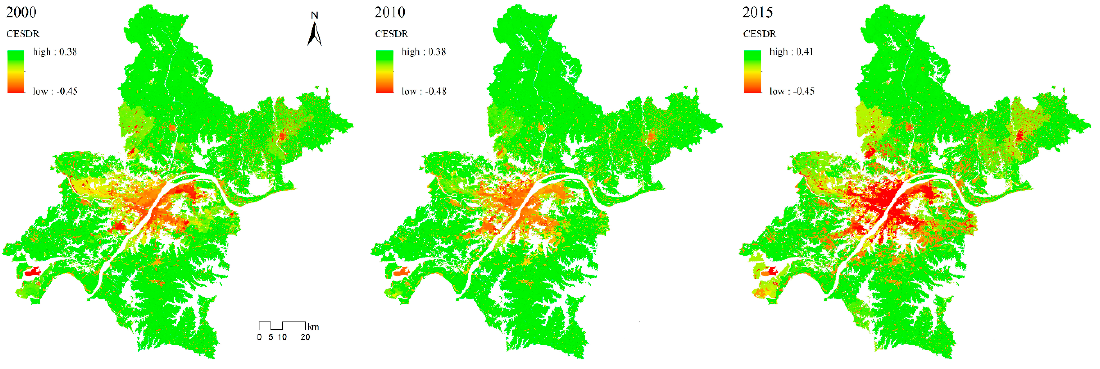
Figure 6. Spatial distribution of the comprehensive ecosystem services supply–demand ratio (CESDR) from 2000 to